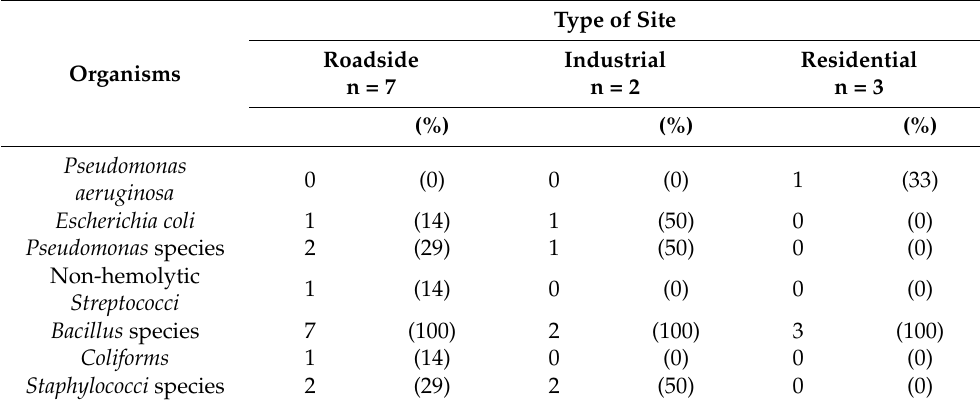
Table 3. Bacteria isolated from post-analyzed ambient air filter papers sampled from three sites (roadside, industrial, residential) in urban Accra, Ghana (February 2020).